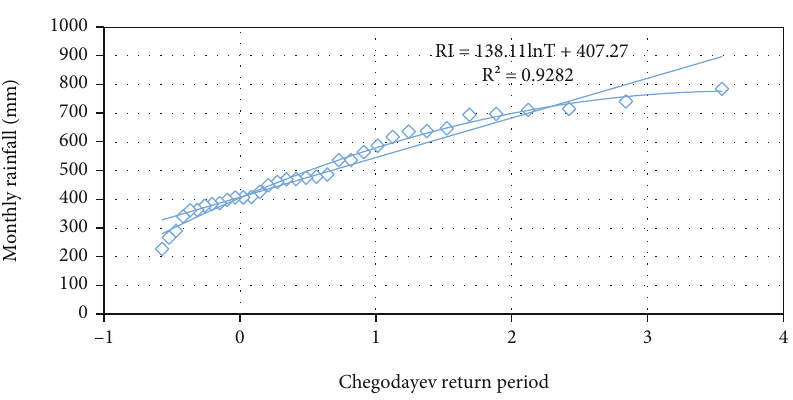
Figure 10: Grigonten ’ s Probability Plotting Position.